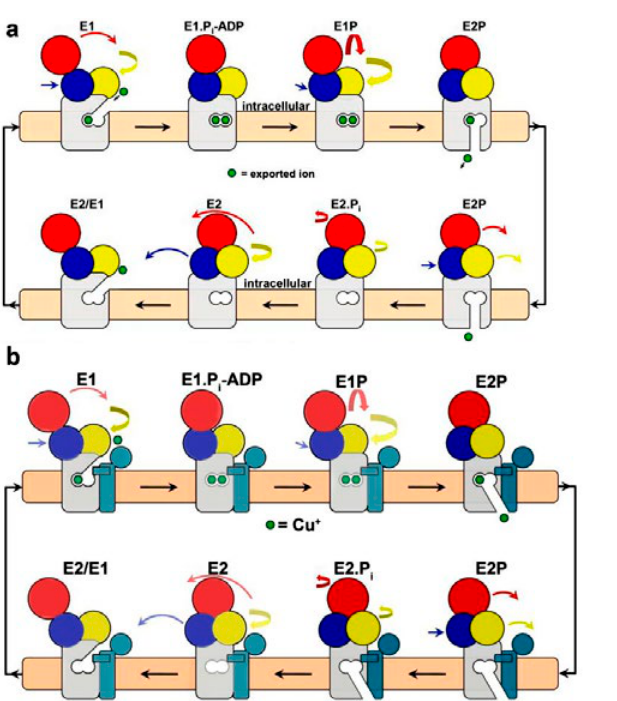
Figure 11. Diagrammatic comparison of the calcium and copper ATPases, showing the sequential conformational transitions of the catalytic and transport cycle. The two transported calcium ions exit the ATPase from the E2P state, and the ion exit pathway closes con- comitantly to hydrolytic cleavage of Pi and transition to the E2.Pi state. On the other hand, the copper ions exit the ATPase from the E2P state, but the exit pathway remains open in the E2.Pi state, and closes only in the E2 state after release of Pi. 30